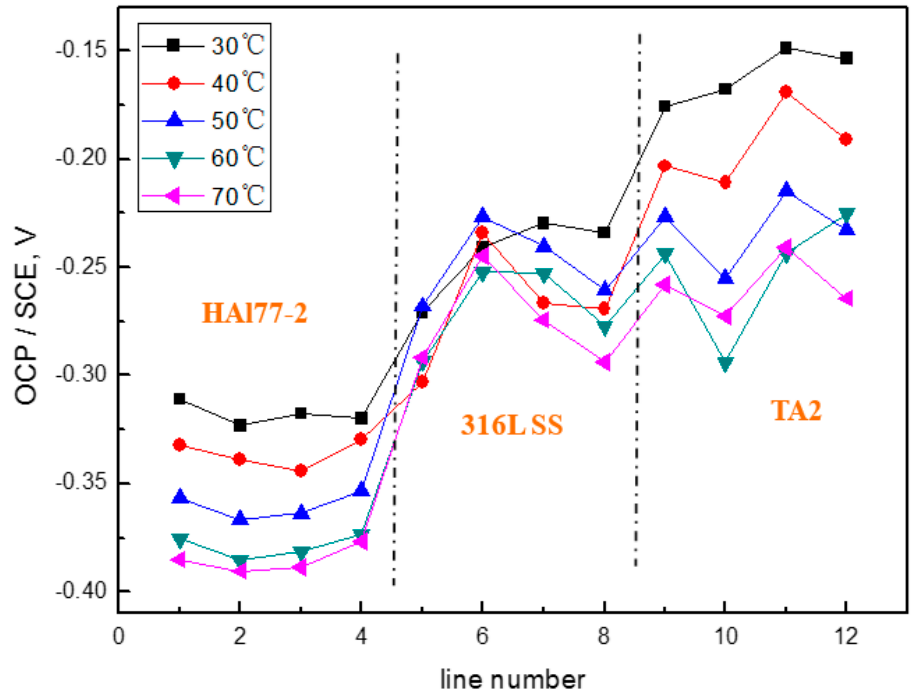
Figure 4. Average OCP distribution of each microelectrode line for WBE1 after immersion in artificial seawater at different temperatures.